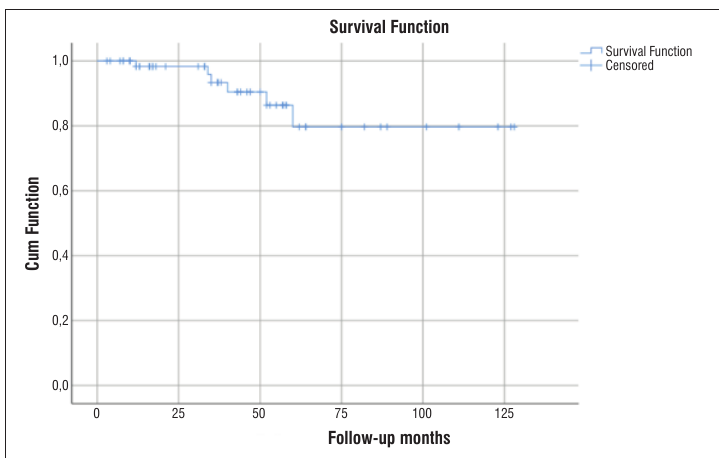
Figure 1. Number of surviving